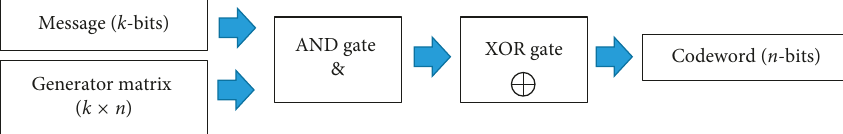
Figure 5: Gate/graphical expression of hamming encoder formula.